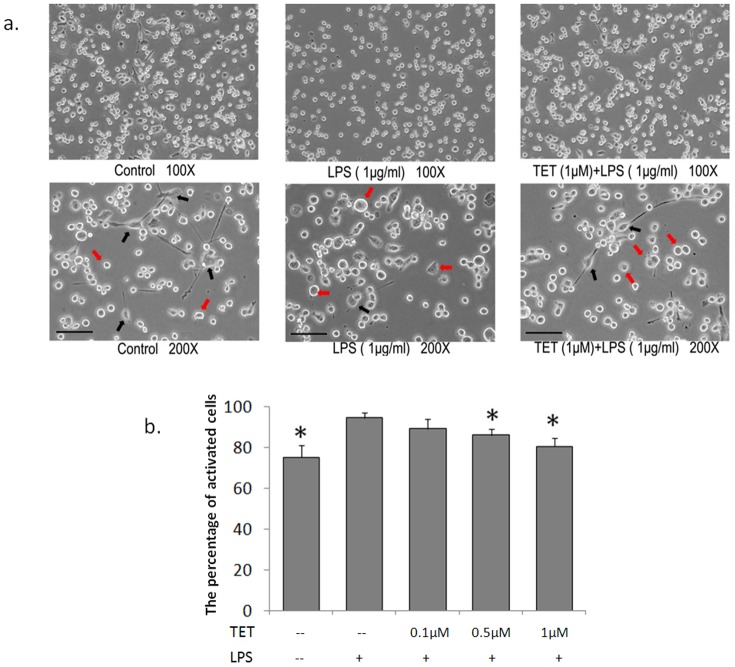
Morphological changes of BV2 cells with or without TET pretreatment (scale bar: 300 µm).BV2 cells were treated with TET at working concentrations for 2 h. Then, LPS was added to each plate and incubated at 37°C for an additional 24 h. Fig. 3a shows the morphological changes of BV2 cells with or without TET pretreatment. Red arrows indicate the activated BV2 cells. Black arrows indicate the basal homeostatic BV2 cells. Fig. 3b: Activated cells and total cells were counted under a phase contrast microscope. Results were expressed as the percentage of activated cells and were the mean ± S.D. from three independent experiments performed in triplicate. * P<0.05 compared with the LPS(+)TET(−) group.